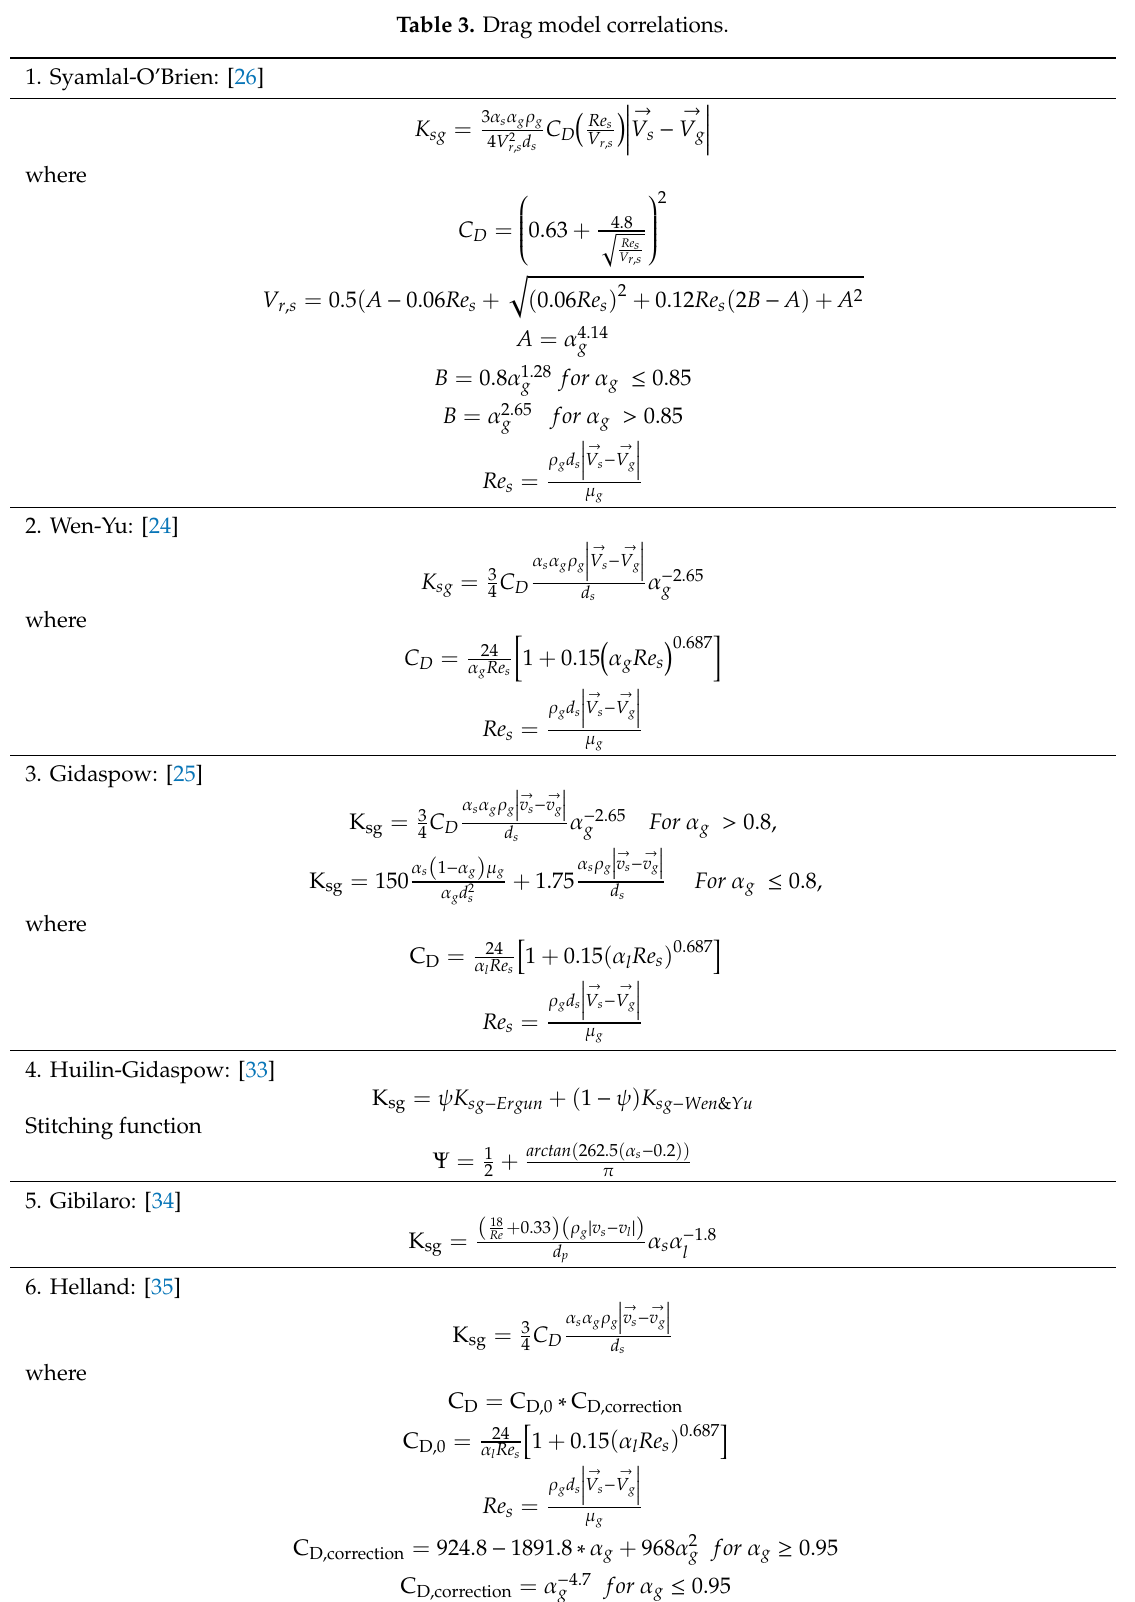
Table 3. Drag model